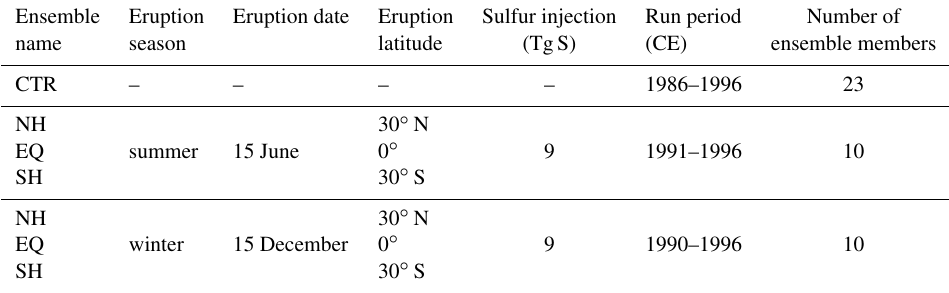
Table 1. Summary of model experiments.